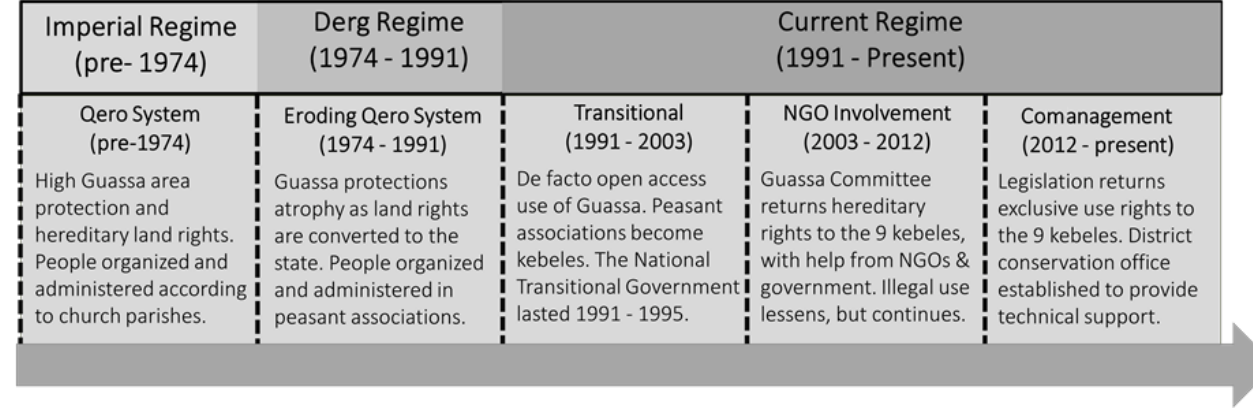
Fig. 2 . A timeline of political and management change in